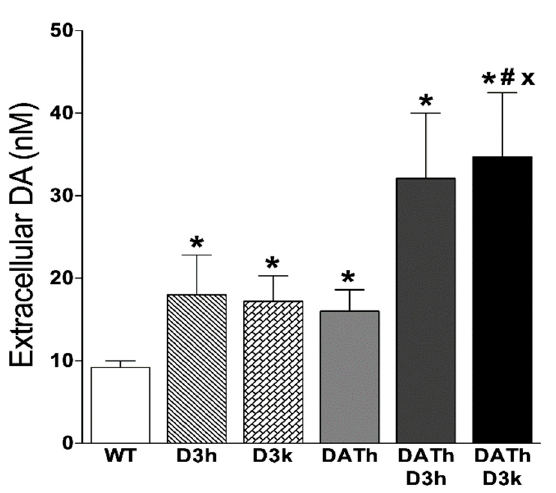
Figure 4. Measures of striatal extracellular dopamine of wild type, DAT, and D3 single mutants and DAT/D3 double mutants detected using quantitative intracerebral microdialysis in freely-moving animals. Values represented in mean ± S.E.M concentration in nM. By comparison, DAT-KO mice demonstrated 48.2 ± 8.1 nM of striatal extracellular dopamine (n = 4) that was significantly different from WT controls ( p < 0.05). * p < 0.05 vs. WT controls; # p < 0.05 vs. DATh group; × p < 0.05 vs. D3k group.